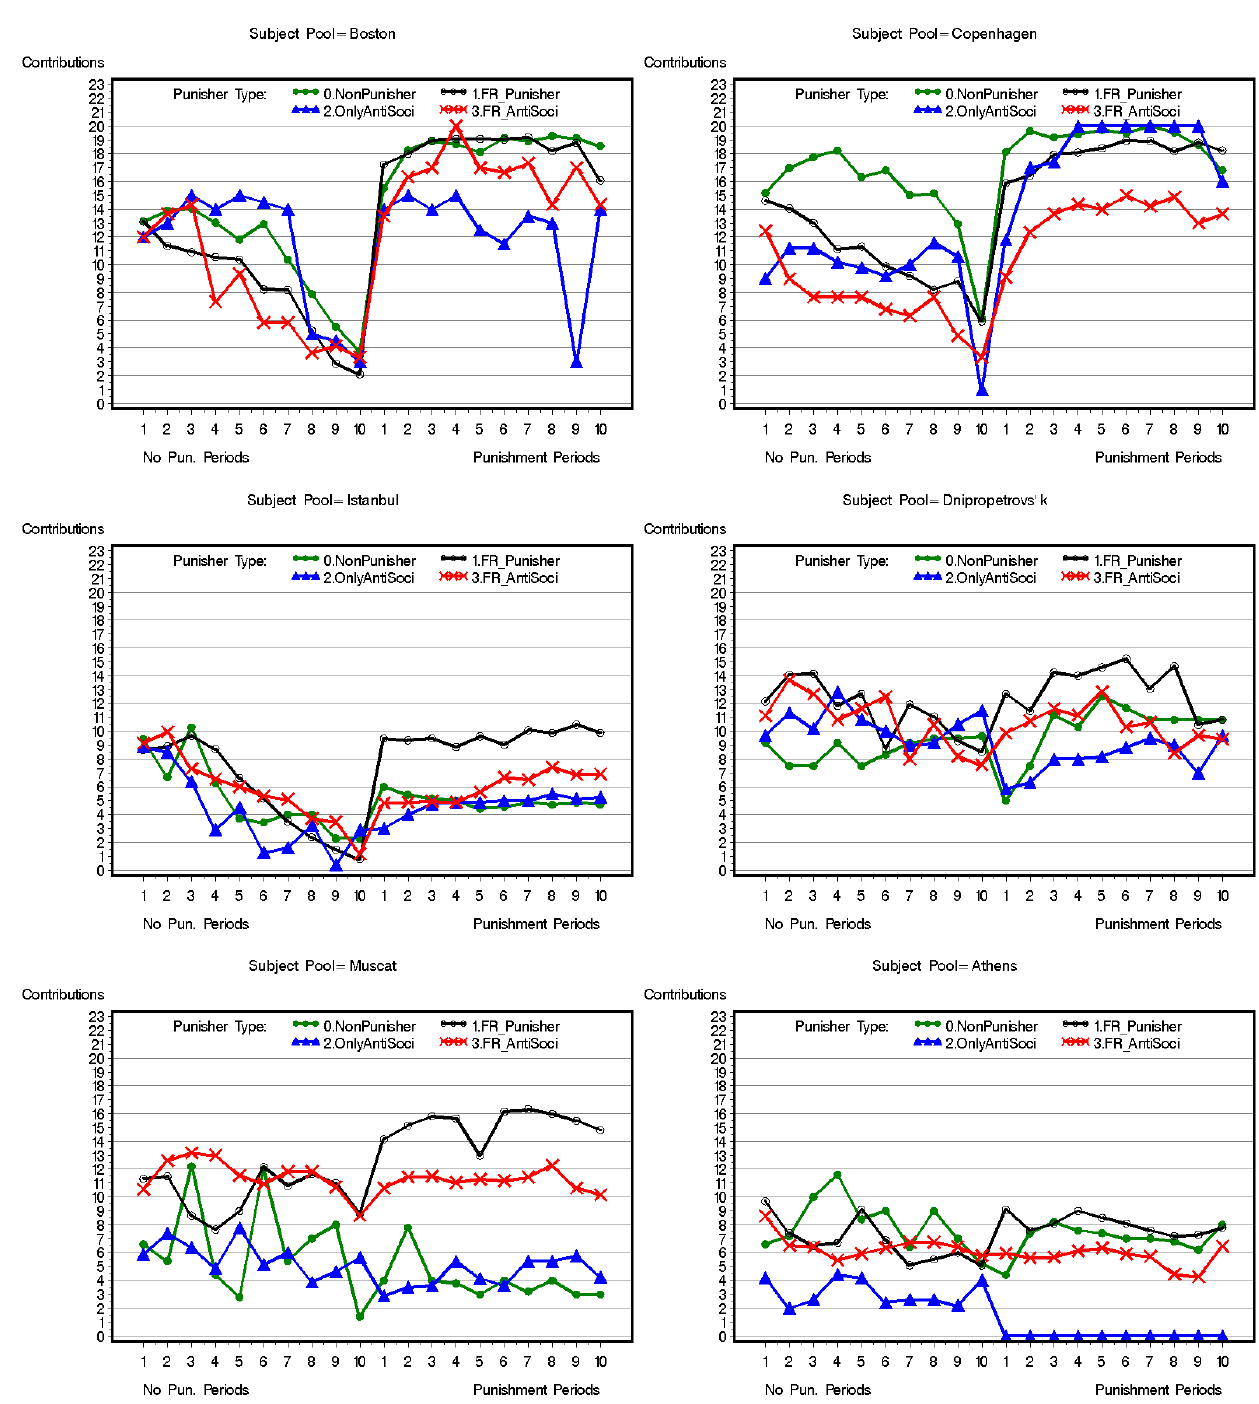
Figure A5. Mean contributions (in MUs) of different punisher types in the no-punishment and punishment phases for representative cities with high, moderate, and low contributions.